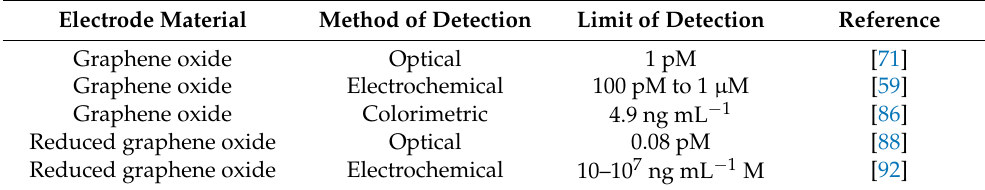
Table 4. Graphene-based detection of dengue virus (Pfu—Plaque forming unit, mL—mililitre, pM— picomolar, µ M—micromolar,